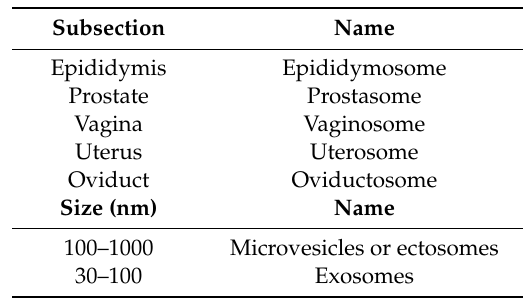
Table 1. Classification of extracellular vesicles (EVs) according to their localization in the reproductive tract or their diameter